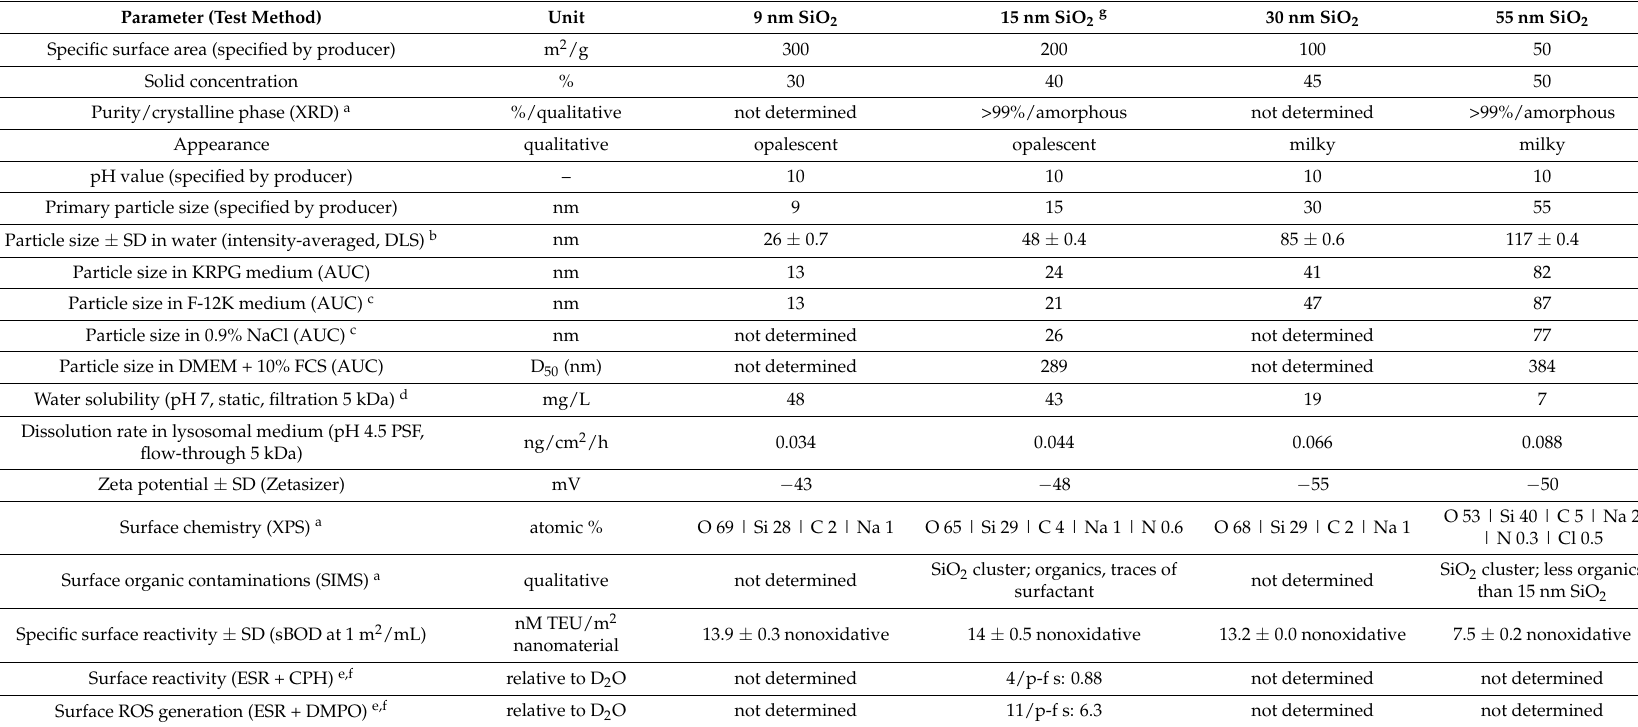
Table 1. Characterization of colloidal amorphous SiO 2 nanomaterials (adapted from Maser et al. [59] and Arts et al. [33]). Parameter (Test Method) Unit 9 nm SiO 2 15 nm SiO 2 g 30 nm SiO 2 55 nm SiO 2 Specific surface area (specified by producer) m 2 /g 300 200 100 50 Solid concentration % 30 40 45 50 Purity/crystalline phase (XRD) a %/qualitative not determined >99%/amorphous not determined >99%/amorphous Appearance qualitative opalescent opalescent milky milky pH value (specified by producer) – 10 10 10 10 nm 9 15 30 55 Particle size ± SD in water (intensity-averaged, DLS) b nm 26 ± 0.7 48 ± 0.4 85 ± 0.6 117 ± 0.4 Particle size in KRPG medium (AUC) nm 13 24 41 82 nm 13 21 47 87 nm not determined 26 not determined 77 D 50 (nm) not determined 289 not determined 384 Water solubility (pH 7, static, filtration 5 kDa) d mg/L 48 43 19 7 Dissolution rate in lysosomal medium (pH 4.5 PSF, ng/cm 2 /h 0.034 0.044 0.066 0.088 flow-through 5 kDa) Zeta potential ± SD (Zetasizer) mV − 43 − 48 − 55 − 50 O 53 | Si 40 | C 5 | Na 2 Surface chemistry (XPS) a atomic % O 69 | Si 28 | C 2 | Na 1 O 65 | Si 29 | C 4 | Na 1 | N 0.6 O 68 | Si 29 | C 2 | Na 1 | N 0.3 | Cl 0.5 SiO 2 cluster; organics, traces of SiO 2 cluster; less organics Surface organic contaminations (SIMS) a qualitative not determined not determined surfactant than 15 nm SiO 2 nM TEU/m 2 13.9 ± 0.3 nonoxidative 14 ± 0.5 nonoxidative 13.2 ± 0.0 nonoxidative 7.5 ± 0.2 nonoxidative Specific surface reactivity ± SD (sBOD at 1 m 2 /mL) nanomaterial Surface reactivity (ESR + CPH) e,f relative to D 2 O not determined 4/p-f s: 0.88 not determined not determined Surface ROS generation (ESR + DMPO) e,f relative to D 2 O not determined 11/p-f s: 6.3 not determined not